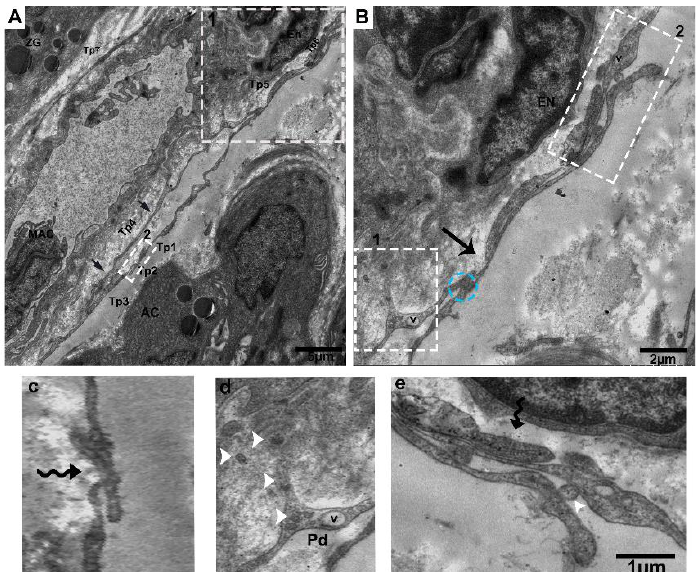
Figure 4. Tps inside and surrounding the interlobular duct with different patterns of long and short overlapping podoms, and podomers within the connective tissue between the acinus. ( A ) Tps forming a long, convoluted process with many overlapping twists (black arrowheads), and the inside of the interlobular duct has podoms with vesicles. Square-marked areas in ( A ) inset into ( B , C ), respectively; ( B ) short overlap and punctate contact (blue circle) and gap junctions, and short overlap (black arrow). ( c ) Hook joint and short overlap with tight junctions between the three Tps. Square-marked areas in ( B ) inset into ( d , e ), respectively; ( d ) shed / extracellular vesicles within the space of the interlobular duct from the podom (white arrowheads). ( e ) A short overlap between podoms to podoms and podomers and shed vesicles (white arrowheads), in closeness to the endothelial cells. Tp, telopodes; MAC, macrophage; AC, acinus; E, endothelial; ZG, zymogen granules; V, vesicles; Pd, podoms. Scale bar = 5 µm in ( A ); scale bar = 2 µm in ( B ); scale bar = 1 µm in ( e ).